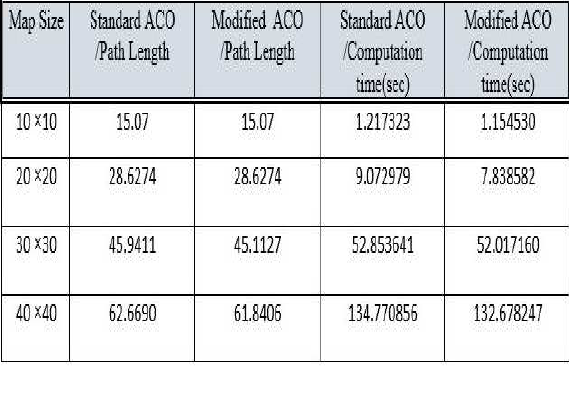
Comparison between Standard ACO and MACO in term of path length and execution